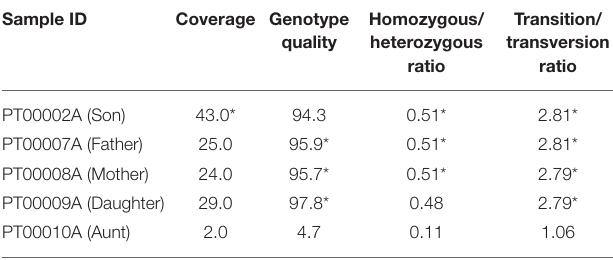
TABLE 1 | Statistics for clinical grade measures of the quality of the variant file.